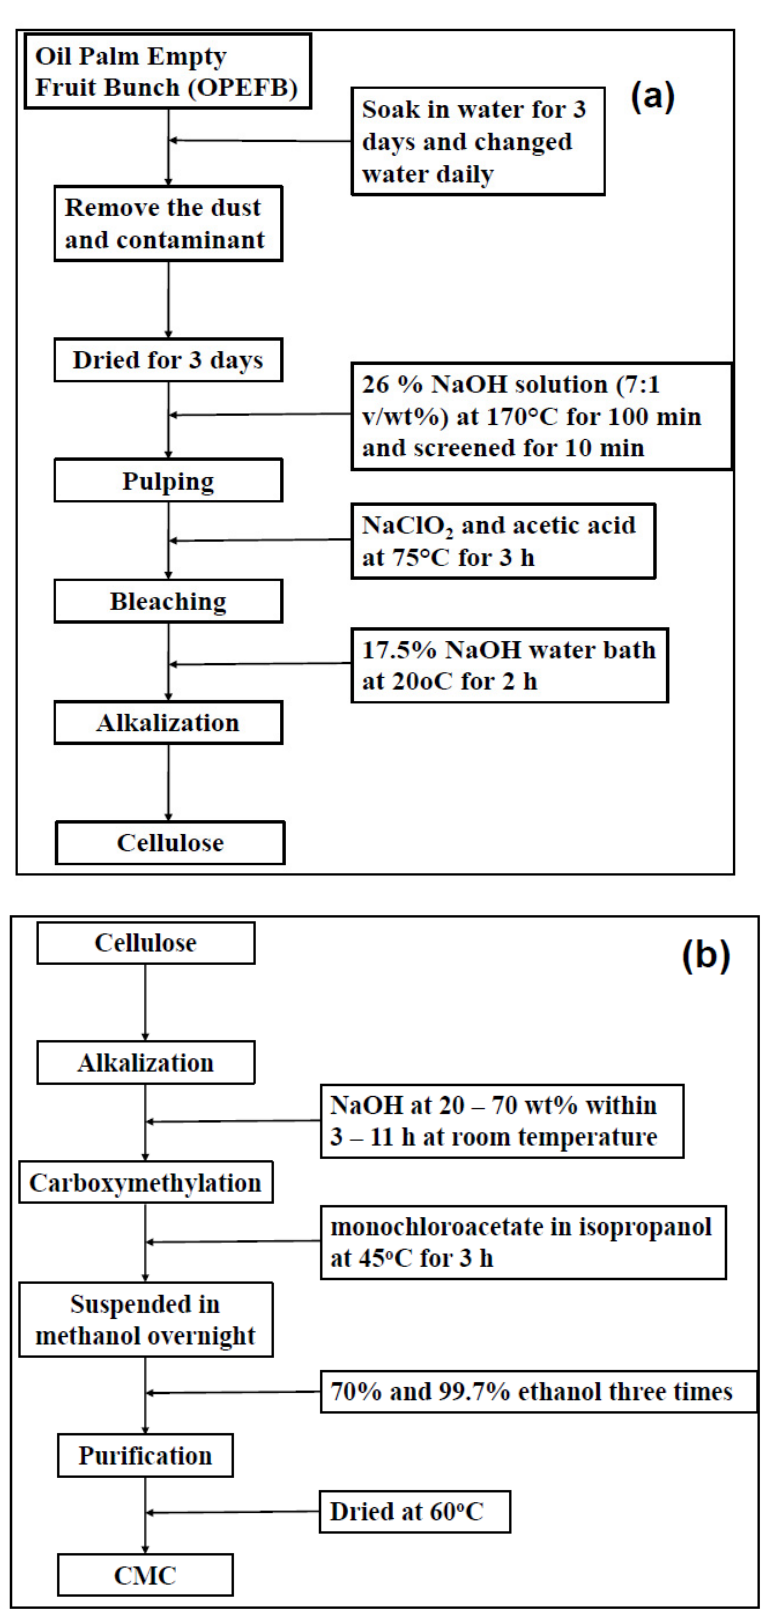
Figure 12. Preparation procedure of cellulose from OPEFB ( a ) and CMC from the extracted cellulose ( b ) .